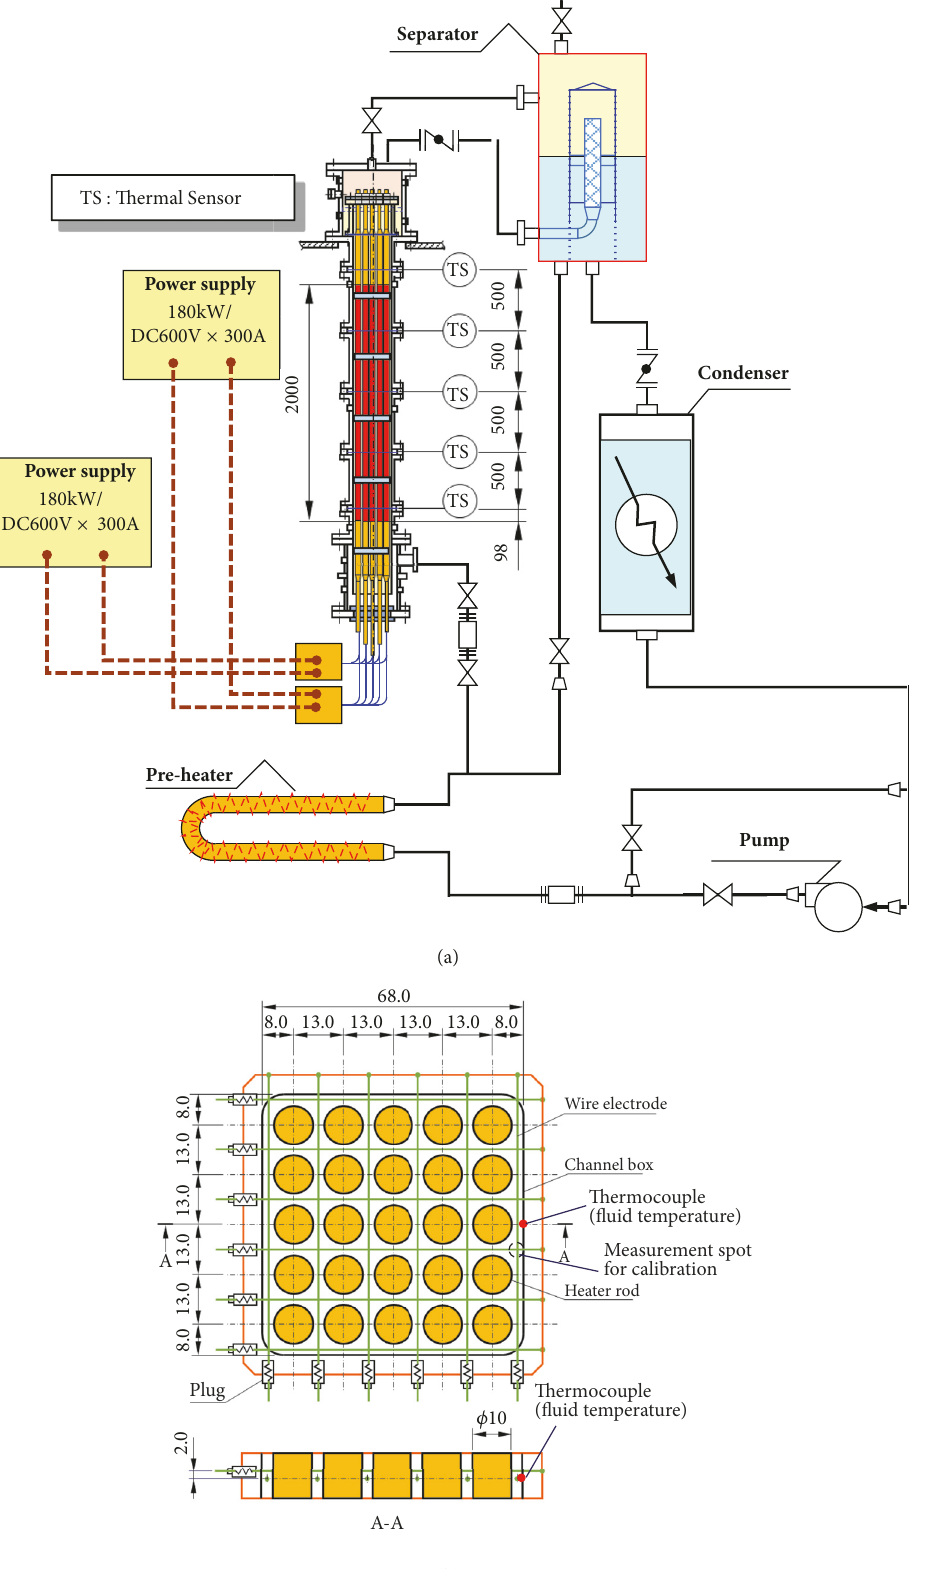
Figure 3: Experimental apparatus with 5 × 5 bundle geometry at z = 598 mm. (a) Main experimental contents, including the bundle test section. (b) Cross-sectional geometry of the temperature